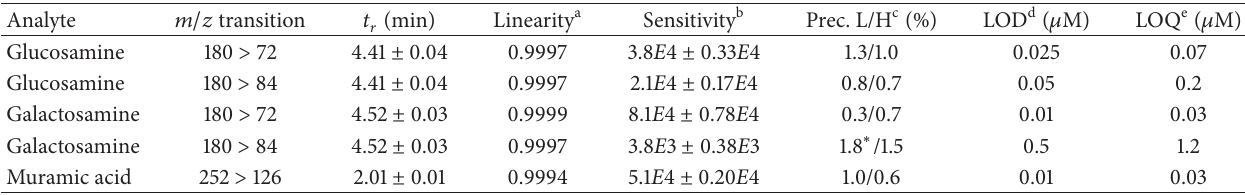
Table 3: LC-MS/MS method performance of retention, linearity, sensitivity, precision, limit of detection, and limit of quantification for glucosamine, galactosamine, and muramic acid.